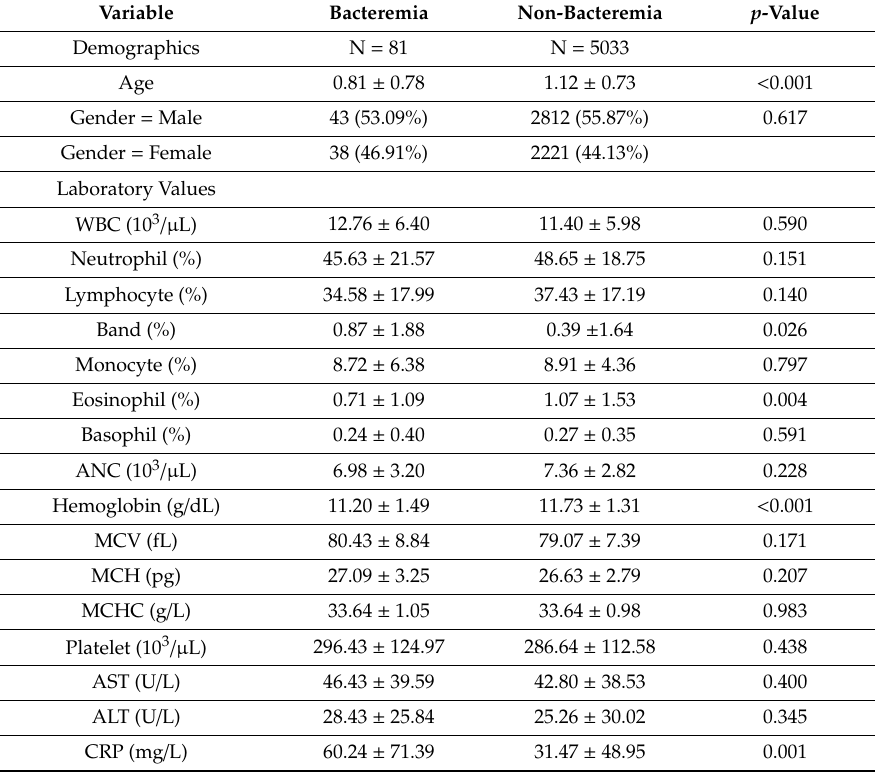
Table 6. Distribution of several variables in febrile children under the age of 3 years old with or without